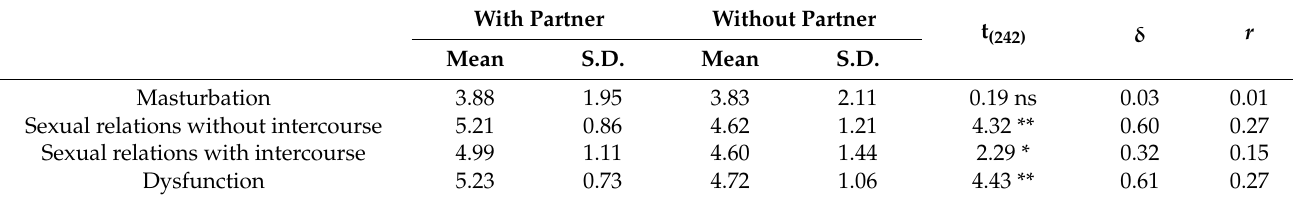
Table 5. Differences in the means of the microsocial dimensions by group. With Partner